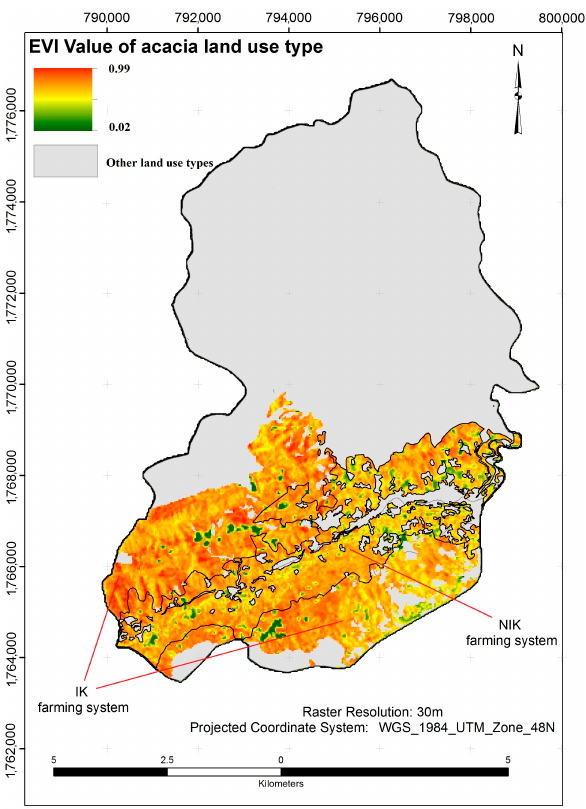
Figure 5. The Enhanced Vegetation Index (EVI) map of IK and NIK farming system areas. Appl. Sci. 2020 , 10 , x FOR PEER REVIEW